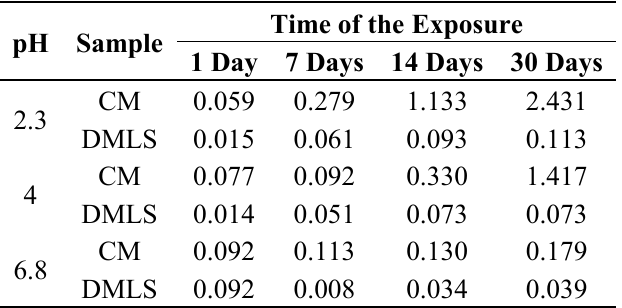
Table 4. The released Mo from the CM and DMLS alloys (μg per cm 2 ) in artificial saliva of pH = 2.3, pH = 4 and pH = 6.8.